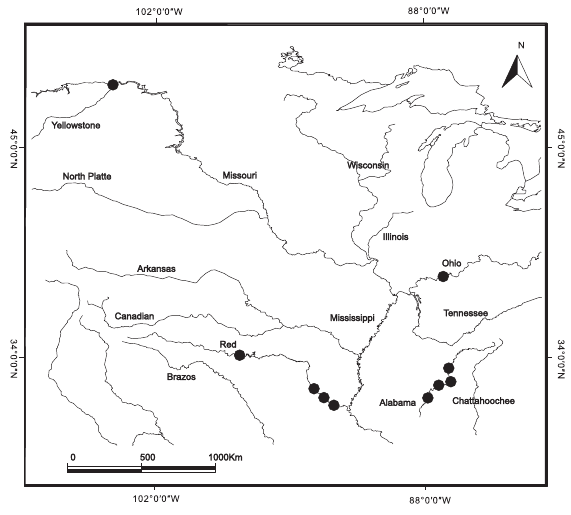
Fig. 1. Map of the Alabama River, Red